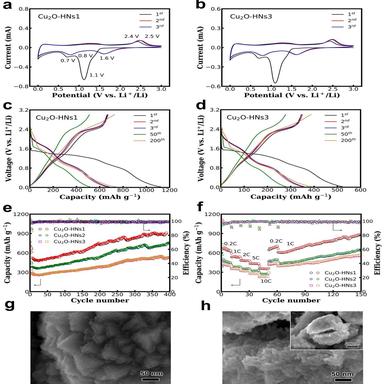
Cyclic voltammetry (CV) curves of (a) Cu2O-HNs1 anode and (b) Cu2O-HNs3 anode at a scan rate of 0.2 mVs−1 in the voltage range of 0.02–3.0 V. Galvanostatic charge/ discharge (GCD) curves of (c) Cu2O-HNs1 anode, and (d) Cu2O-HNs3 anode. (e) The cycle performance of anodes at 1 C, and (f) the rate capabilities. SEM images of Cu2O-HNs3 anode after 50 cycles (g) the surface morphology, and (h) the cracked sphere.